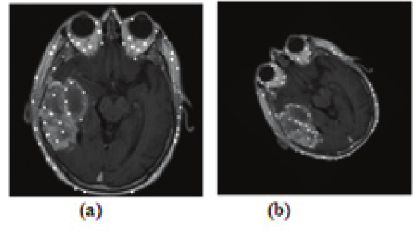
Figure 9. (a) Feature point image (b) Rotation by 45